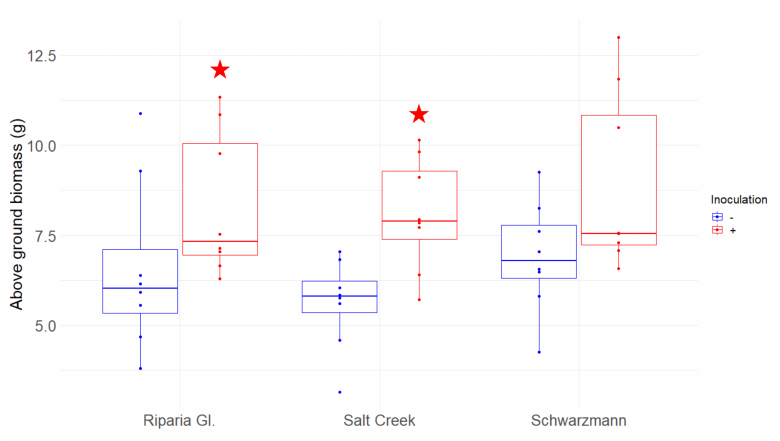
Figure 1. Above ground biomass (grams) of greenhouse-grown rootstocks during the first year. Blue plots represent uninoculated while red plots represent inoculated rootstocks. Red stars above inoculated plots depict significant positive AM fungal response compared to uninoculated control. Statistical analysis was performed on the log